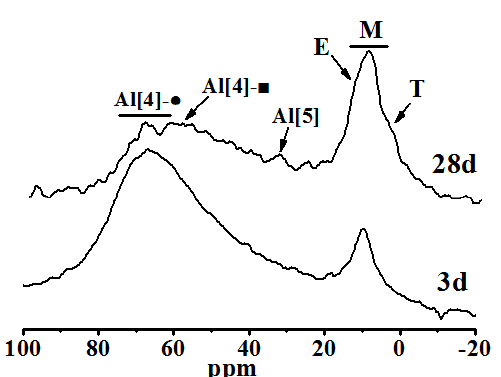
Figure 7. 27 Al NMR spectra of hydrated pastes at different ages.